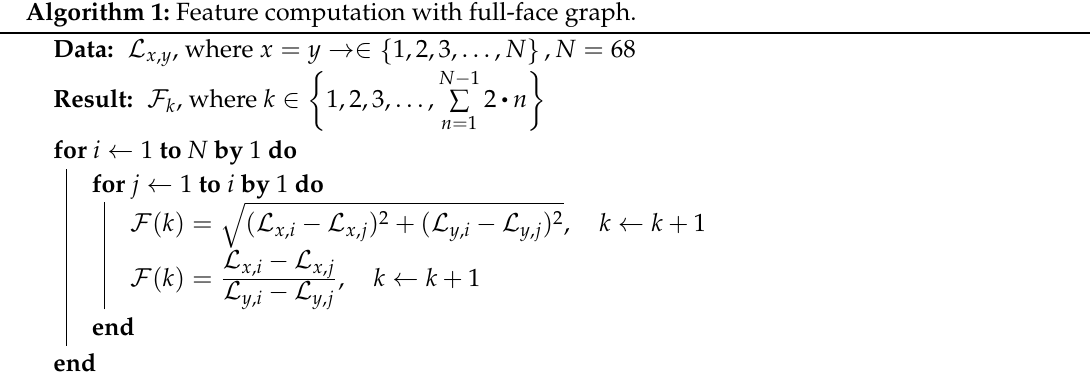
Algorithm 1: Feature computation with full-face